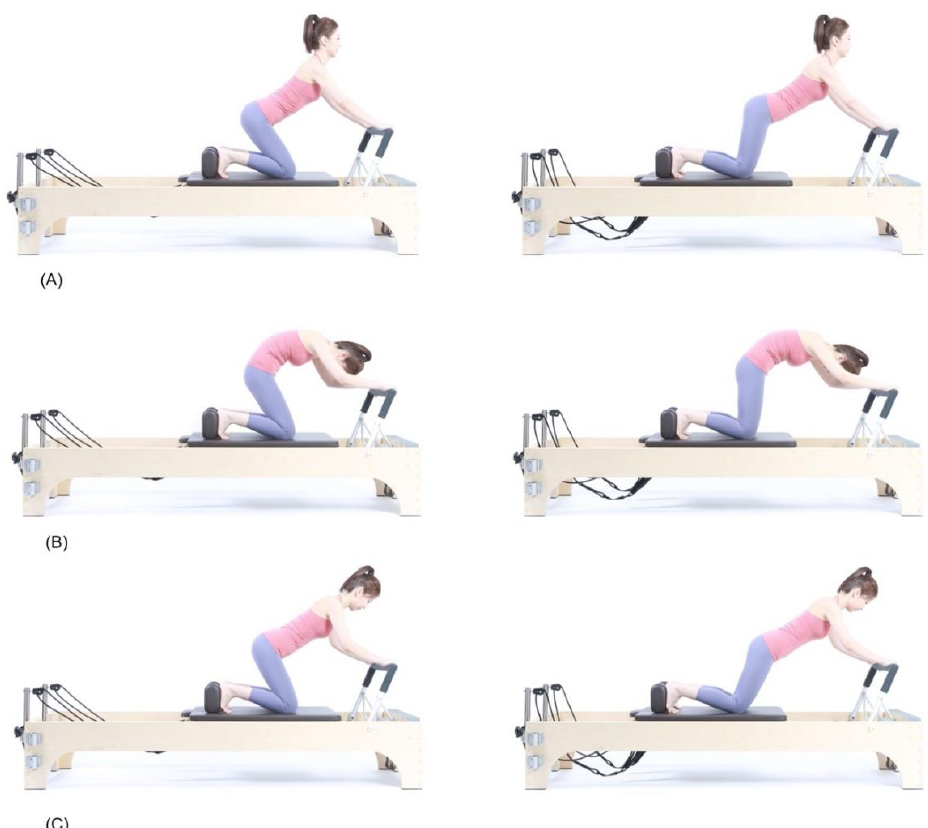
Figure 1. Knee stretch exercise. ( A ) Starting position (left) and end position (right) of the extended back with an anteriorly back with an anteriorly tilted pelvis (EAP) position. ( B ) Starting position (left) and end position tilted pelvis (EAP) position. ( B ) Starting position (left) and end position (right) of the round back with a posteriorly tilted (right) of the round back with a posteriorly tilted pelvis (RPP) position. ( C ) Starting position (left) pelvis (RPP) position. ( C ) Starting position (left) and end position (right) of the flat back with a neutral pelvis (FNP) posi- tion. and end position (right) of the flat back with a neutral pelvis (FNP)